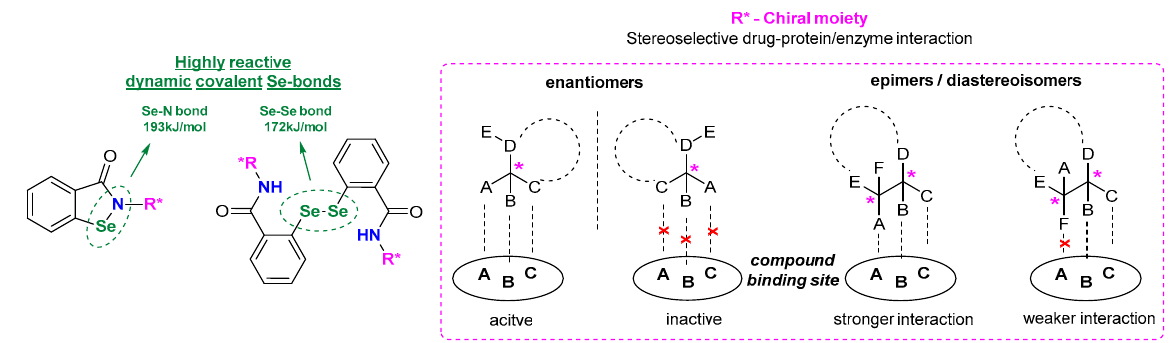
Figure 2. Structural features of the designed compounds—interaction with the target binding sites.